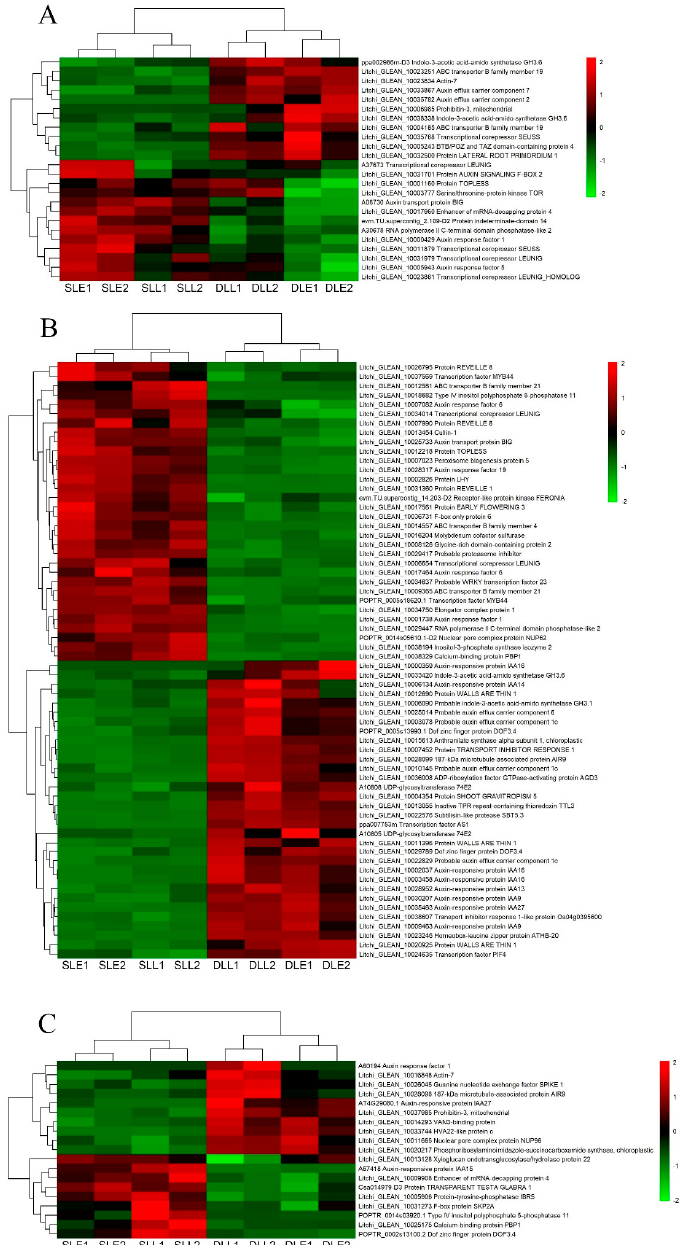
Figure 6. Heat map diagram showing the IAA-related differentially expressed genes (DEGs) between senescing and developing panicle leaves. ( A ) The unique DEGs expressed at an early stage. ( B ) The DEGs simultaneously expressed at early and later stages. ( C ) The unique DEGs expressed at a later stage. Litchi trees were transferred to a growth chamber at 18 °C to induce panicle leaf senescence when panicle primordia emerged. The other trees were transferred to a growth chamber at 26 °C to encourage panicle leaf development. FPKM values of the samples were normalized to Z-score.